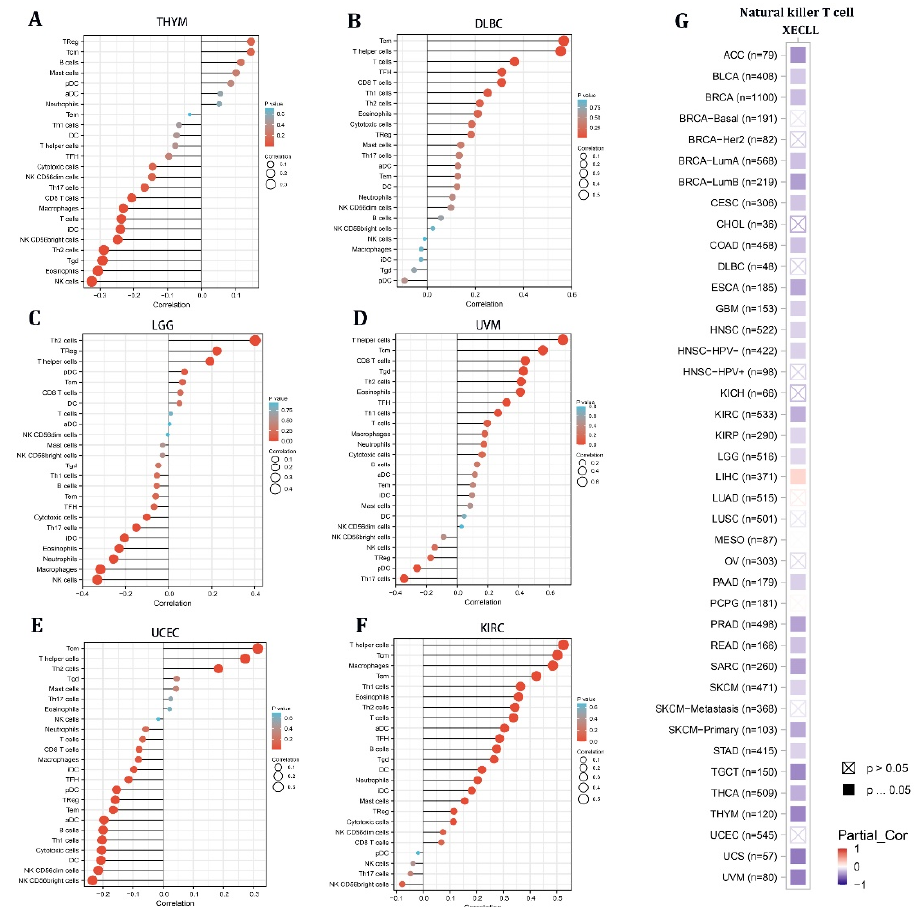
Figure 4. The level of STX6 in cancer tissue can predict the infiltration degree of NK cells and T helper cells. The results of single ‐ sample gene set enrichment analysis (ssGSEA) for STX6 protein showed that malignant tissues with greater STX6 levels exhibited a larger percentage of TCM cells and T helper cells, but lower NK cell levels ( A – F ). Furthermore, STX6 was significantly negatively correlated with NKT cells in pan ‐ cancer according to the TIMER database ( G ).